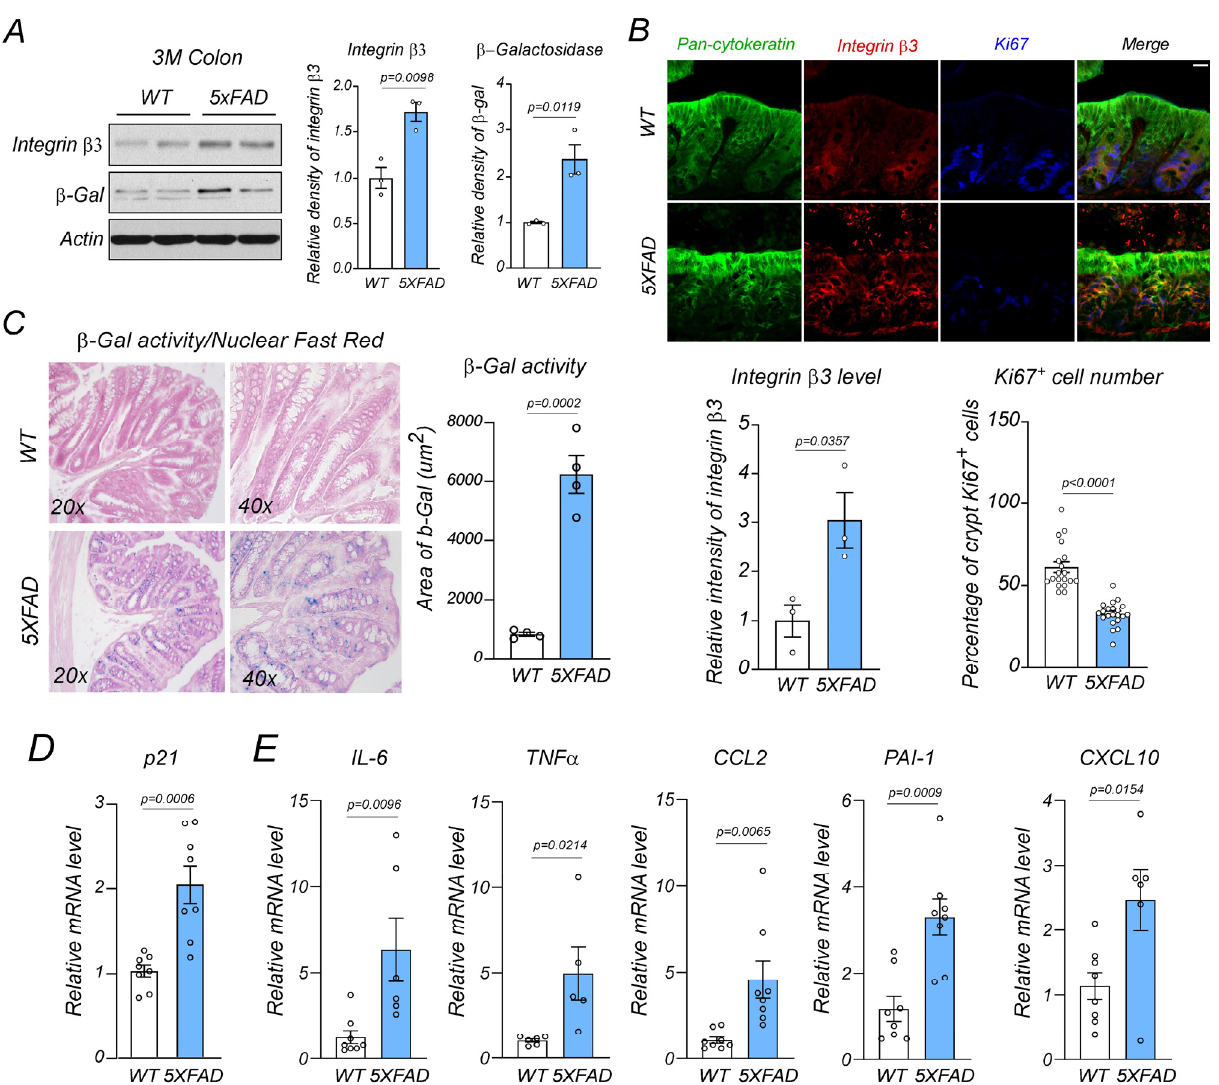
Figure 5. Integrin β 3 upregulation and senescence in the AD mouse colon. ( A ) Integrin β 3 and β -galactosidase ( β -gal) protein levels were examined using western blotting in wild-type (WT) and 5XFAD mouse colons at 3 months (3M) ( n = 3 mice/group). ( B ) Co-immunofluorescence staining of colon mucosal epithelium using anti-pan-cytokeratin, anti-integrin β 3, and anti-Ki67 antibodies in WT and 5XFAD mice at 3 months. Relative integrin β 3 immuno-intensity and Ki67 + cell percentages/colon crypt are shown ( n = 3 mice/group. Scale bar = 25 μ m). ( C ) β -galactosidase activity was determined via X-gal staining and followed by nuclear fast red staining in WT and 5XFAD mouse colonic sections at 3 months ( n = 4 mice/group). ( D ) p21- and ( E ) senescence-associated secretory phenotype-related gene mRNA levels were determined via a RT-qPCR in WT and 5XFAD mouse colons at 3 months. ( n = 8 mice/group). Data were expressed as the mean ± standard error of the mean and compared using unpaired Student’s t -tests.